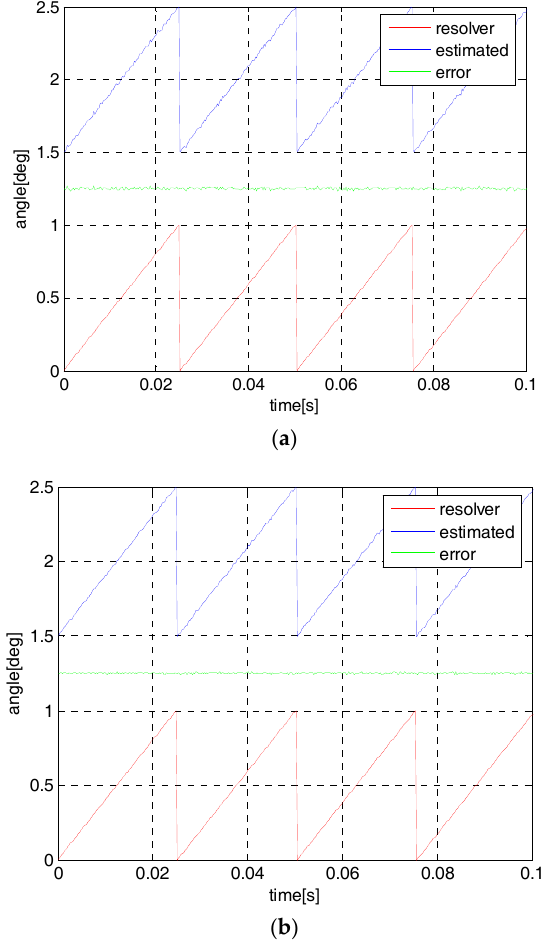
Figure 7. The simulated angle and its estimation at 1200 rpm by using one ‐ step observer ( a ) and two ‐ step observer ( b ).